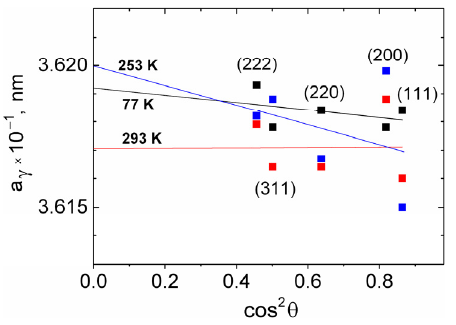
Figure 8. The austenite lattice parameters for the hkl planes at ψ = 0 (in the Bragg–Brentano geometry) in the Cr-Mn-N steel after the tensile tests at 293, 253, and 77 K.